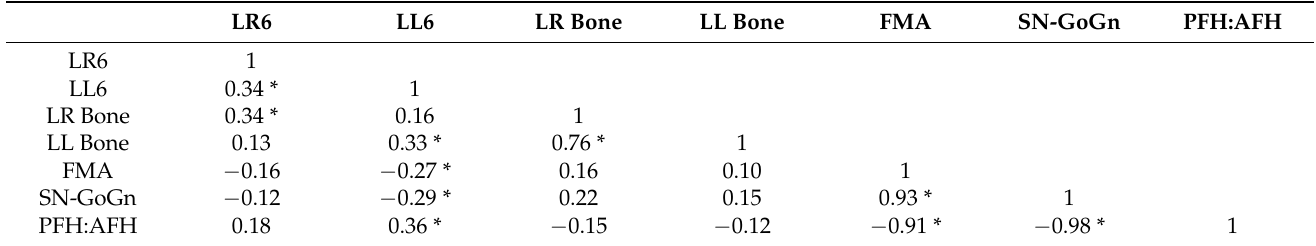
Table 2. Correlation coefficient (r) among mandibular first molars, alveolar bones, and vertical cephalometric